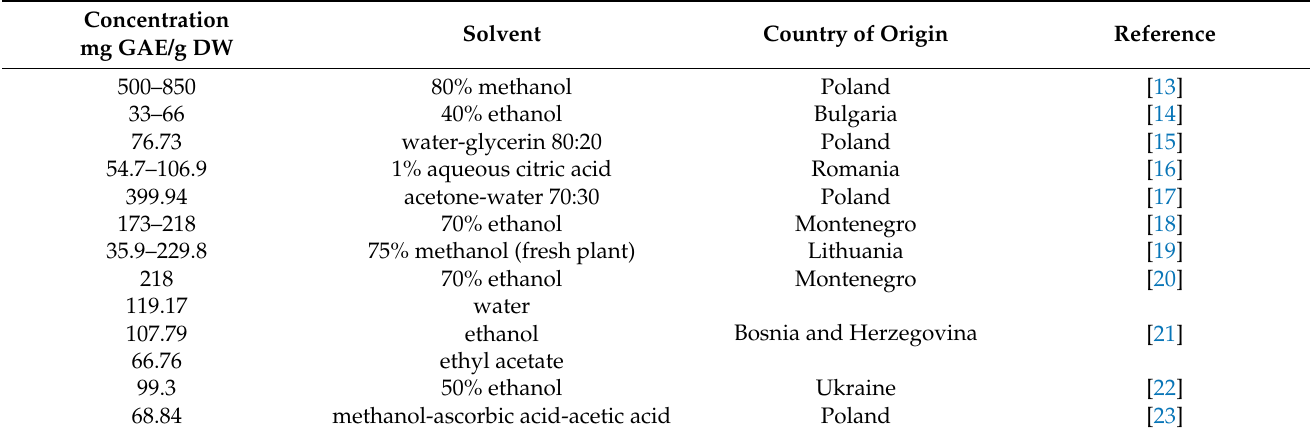
Table 1. Total polyphenolic content reported in several studies.